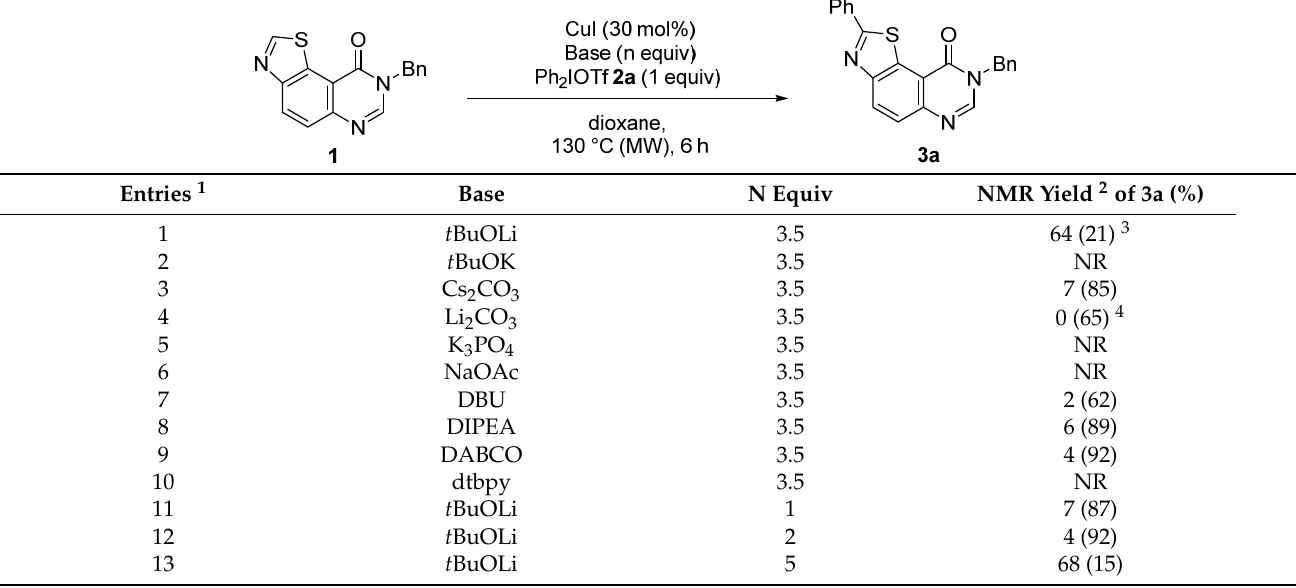
Table 2. Screening of the base.